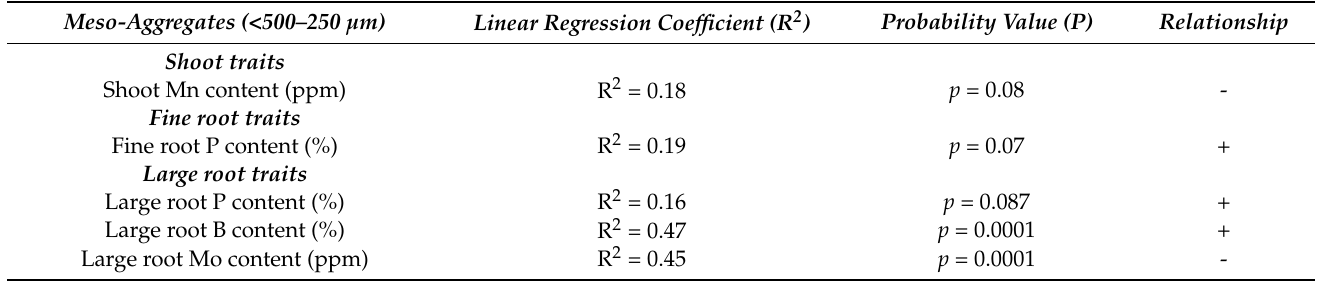
Figure 5. The relationship between the organic carbon contents (%OC) of soil mesoaggregates and plant traits, as determined by linear regression. Only significant ( p< 0.05 ) relationships are plotted ( a – n ). The abbreviations are LR (large roots), FR (fine roots), Sht (shoot), LAdTri (leaf adaxial trichome density), and LAbTri (leaf abaxial trichome density). The trichome density was number of trichomes per 0.29 cm 2 of soybean leaf area. Table 3. Relationship between abundance of mesoaggregates (<500 – 250 μm) and plant traits.